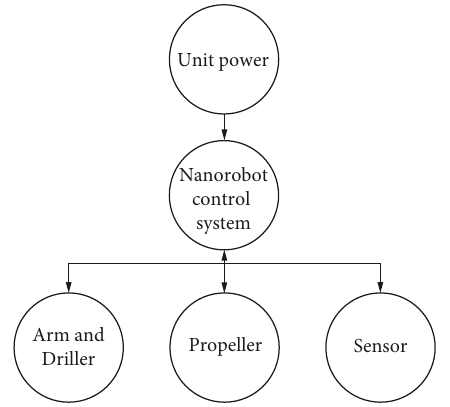
Figure 1: Block diagram of nanorobots control